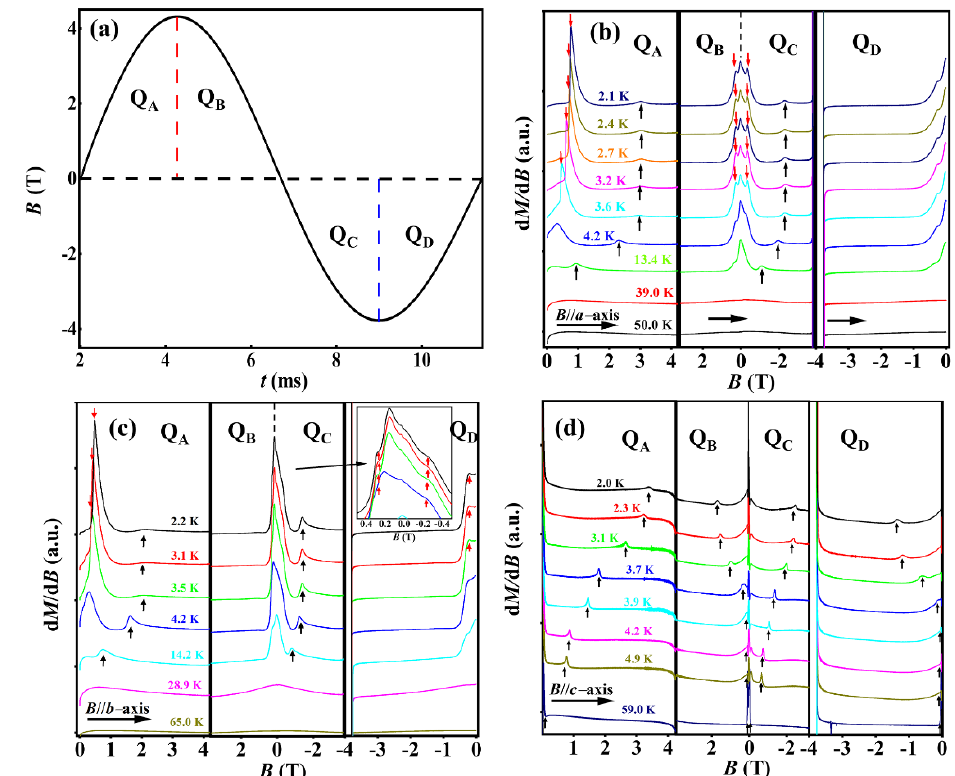
Figure 4. ( a ) The waveform of the pulsed magnetic field. ( b – d ) Magnetization derivative (d M /d B ) as a function of the magnetic field measured along the three principal axes. The inset in ( c ) is the enhancement of the d M /d B around the zero-magnetic-field regions. The curves of ( b – d ) are offset for clarity. Q A , Q B , Q C , and Q D are the four quadrants of the pulsed magnetic field; all the transitions are labeled with arrows.